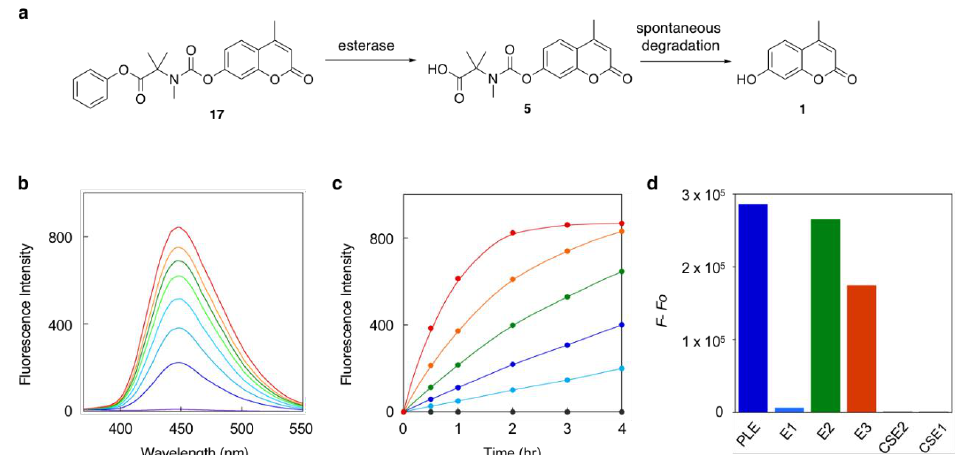
Figure 3. Fluorescence detection of esterase-catalyzed hydrolysis of the probe 17 . ( a ) Sequential reaction of 17, consisting of esterase-catalyzed hydrolysis and subsequent spontaneous degradation. ( b ) Fluorescence spectral change of 17 upon incubation with PLE (1.0 unit) for 0, 0.5, 1, 1.5, 2, 2.5, 3, and 4 h (from bottom to top). ( c ) Time-trace plots of change in fluorescence intensity ( λ em = 450 nm) upon incubation of 17 with 0, 0.1, 0.25, 0.5, 1, and 2 units of PLE (from lower to upper curve). ( d ) Fluorescence intensity change of 17 ( λ em = 450 nm) upon incubation with various esterases for 3 h. Measurement conditions: [ 17 ] = 5 µ M, 50 mM HEPES, pH 7.4, 37 ◦ C, λ ex = 320 nm.